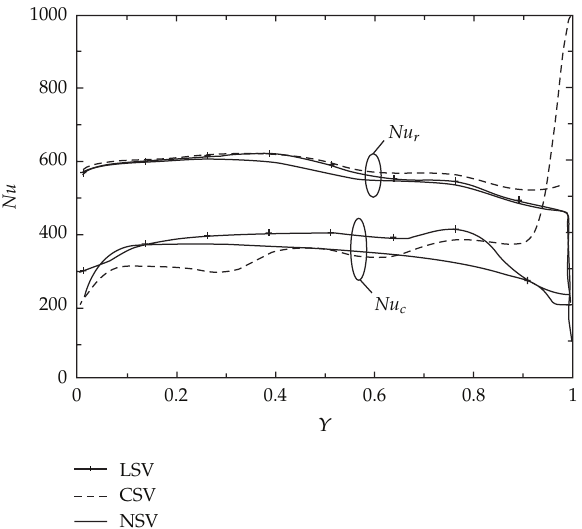
Figure 8: Nu c and Nu r distribution along the outside wall for the cases shown in Figure